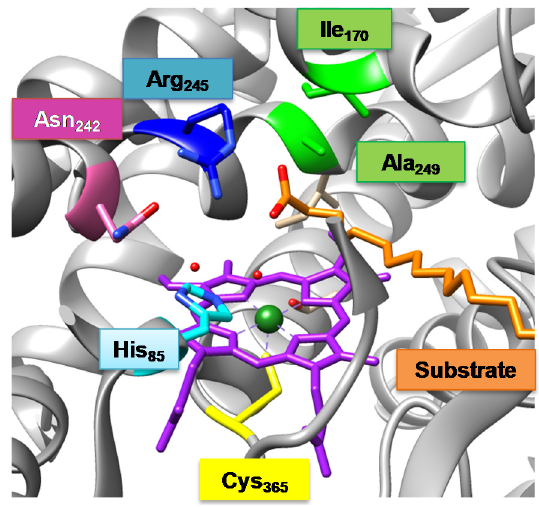
Figure 1. Active site structure of P450 OleT JE as taken from the 4L40 pdb file.